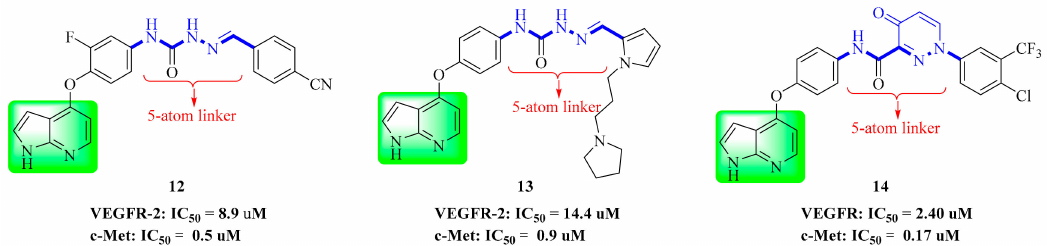
Figure 7. Pyrrolopyridine derivatives of dual VEGFR / c-Met inhibitors.